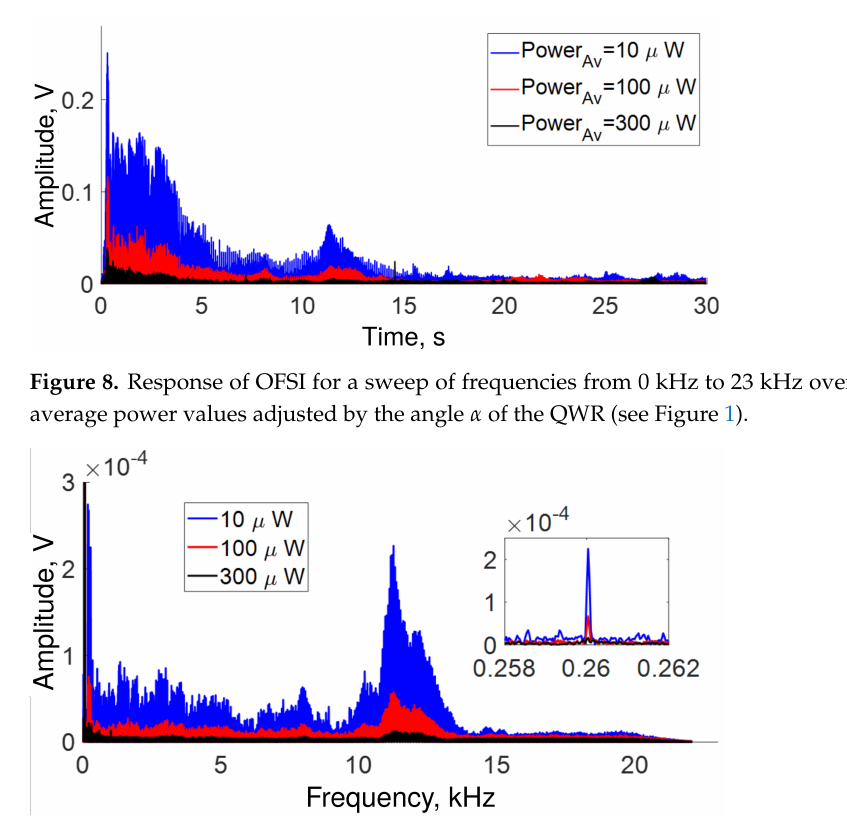
Figure 9. All frequencies detected in our setup for several values of average power adjusted by the angle α of QWR (see Figure 1). The inset shows a zoom on frequencies around 0.26